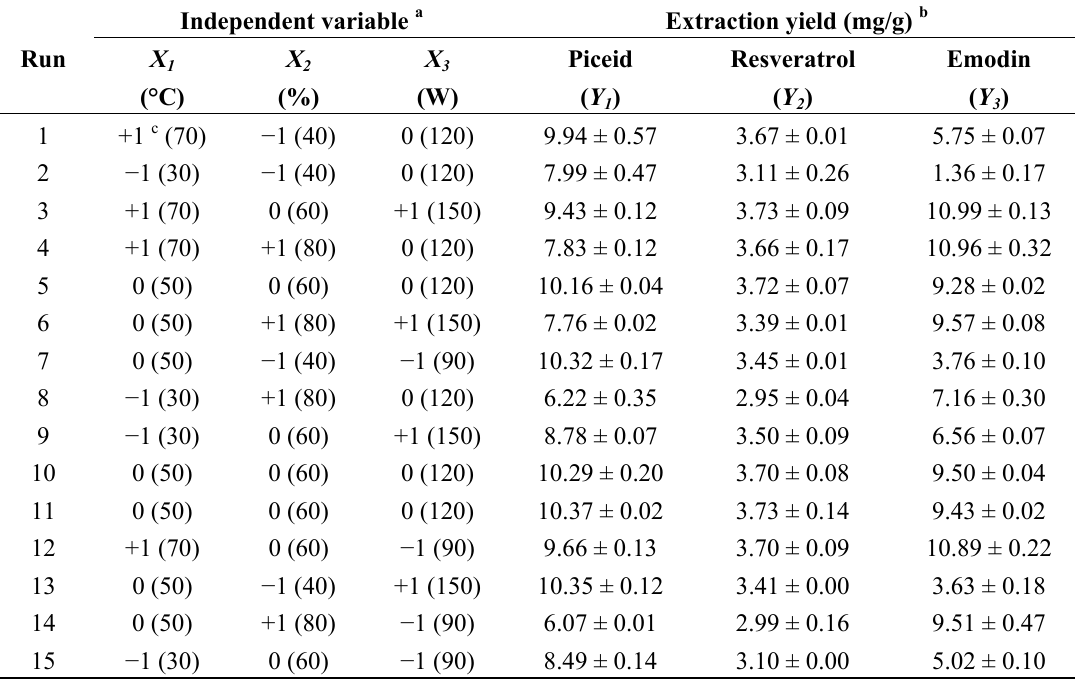
Table 1. Box-Behnken design and observed experimental data for 3-level–3-factor RSM.